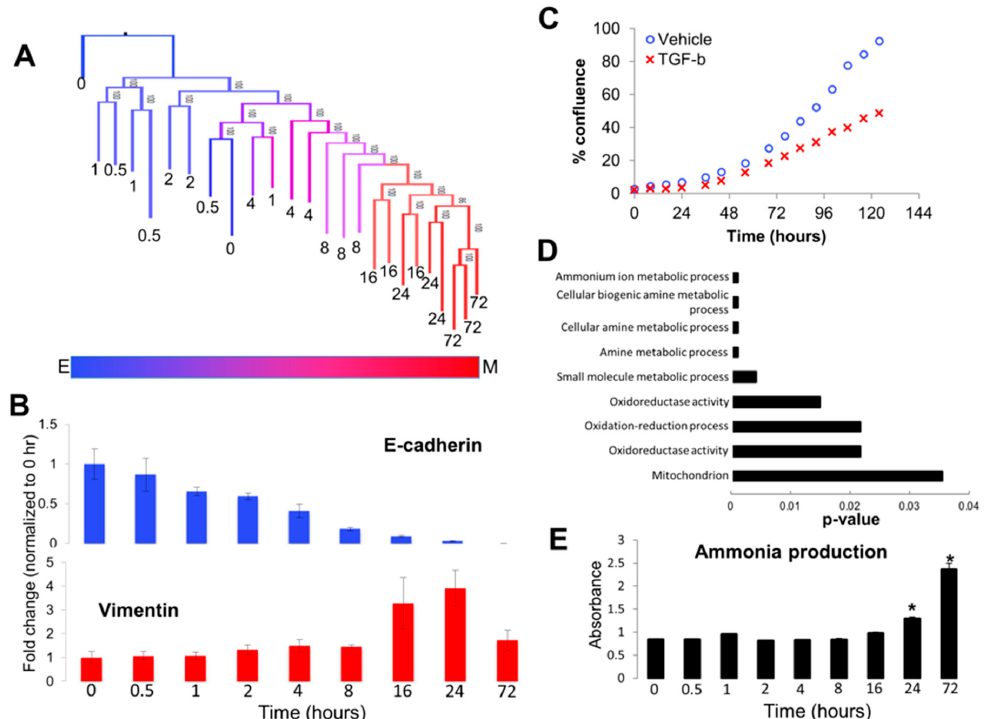
Figure 4. Visualization of tree topology reveals altered metabolism during epithelial–mesenchymal transition (EMT). ( A ) The topology of the maximum-likelihood reconstruction of GSE17708 showed an admixed clade at early time points in A549 cells with TGF- β treatment, with a clearly-resolved clade of later time points after eight hours as the phenotypic signal switched from epithelial to mesenchymal. ( B ) Consistent with the tree topology, changes in EMT biomarkers E-cadherin and vimentin were not apparent until after eight hours of treatment. * indicate p < 0.05 as compared to the 0 h time point ( C ) Growth curves of A549 cells treated with vehicle (blue circles) or TGF- β (red × ) analyzed by IncuCyte time-lapse imaging revealed TGF- β -induced growth inhibition at 48–72 h. ( D ) Pathway analysis of genes contributing to the bifurcation of early (<8 h) and late ( ≥ 8 h) time point clades revealed TGF- β -induced changes in amine metabolism pathways at the later time points as compared to the early time points. ( E ) Ammonia production assays validated the prediction that TGF- β induces upregulation of ammonia